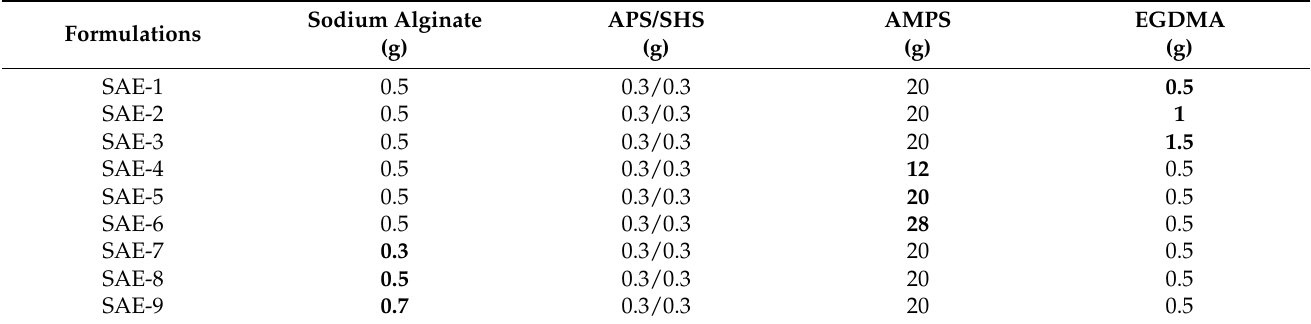
Table 3. Different formulations of SA- g -AMPS hydrogels based on various feed compositions.